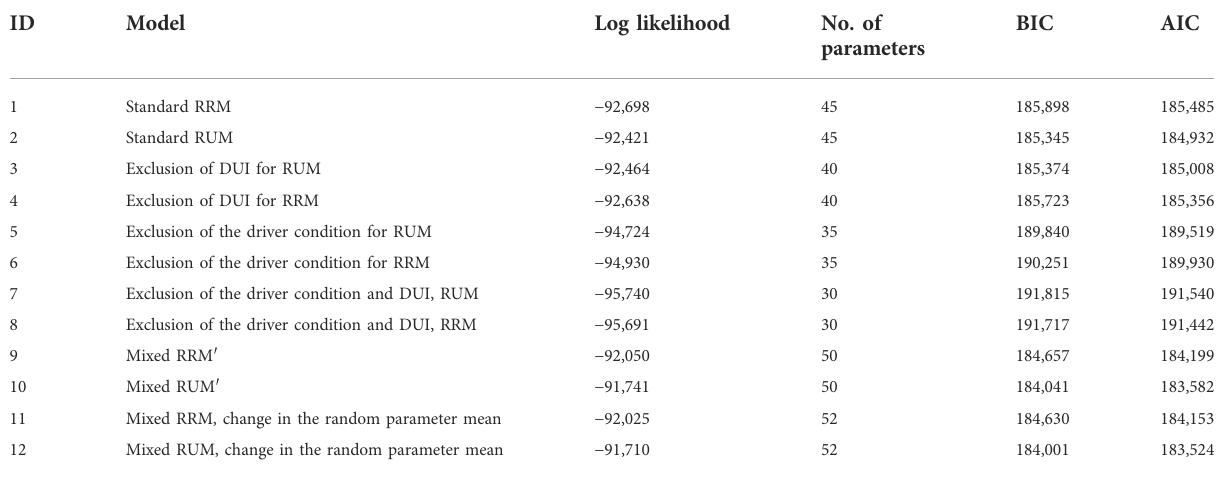
TABLE 2 Comparison across various considered